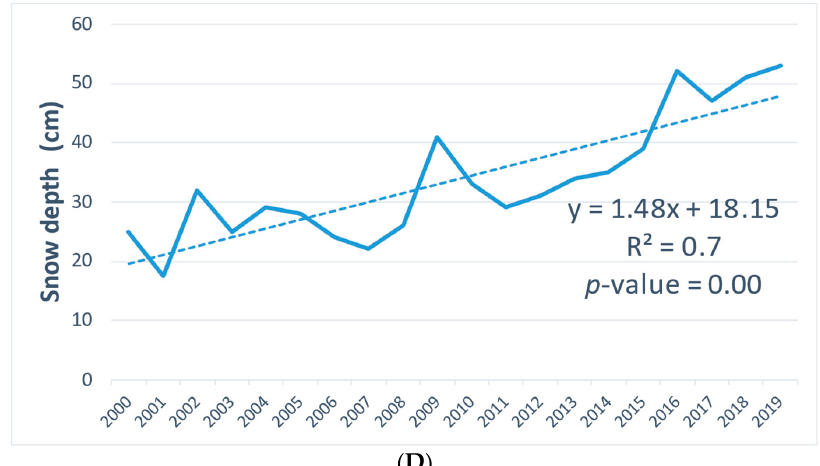
Figure 7. Climate trends at Tazovskiy Village. ( A ) mean annual temperature (°C); ( B ) mean winter (October to April inclusive) temperatures (°C); ( C ) mean summer precipitation (mm) (June, July, and August); ( D ) mean snow depth (November to March inclusive) (cm).